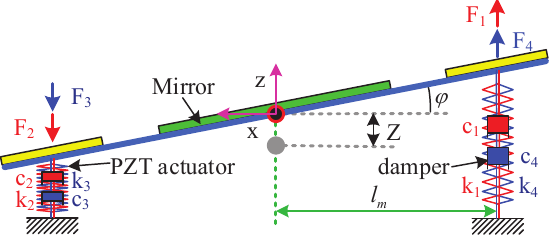
Figure 4. Schematic diagram of the flexible piezoelectric nano-positioning